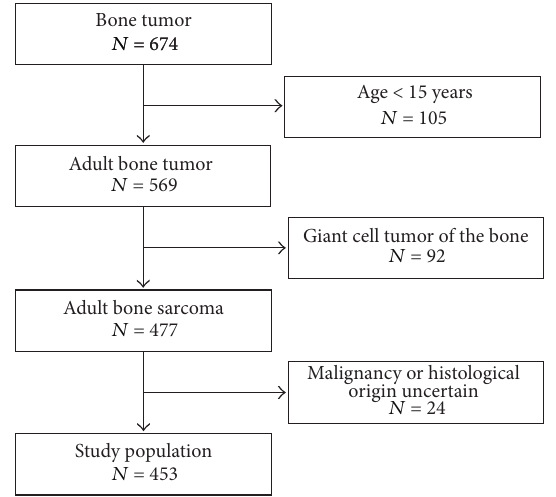
Figure 1: Flow chart for patients diagnosed with a bone sarcoma at the Sarcoma Centre of Aarhus University Hospital in the period from 1979 to 2008.